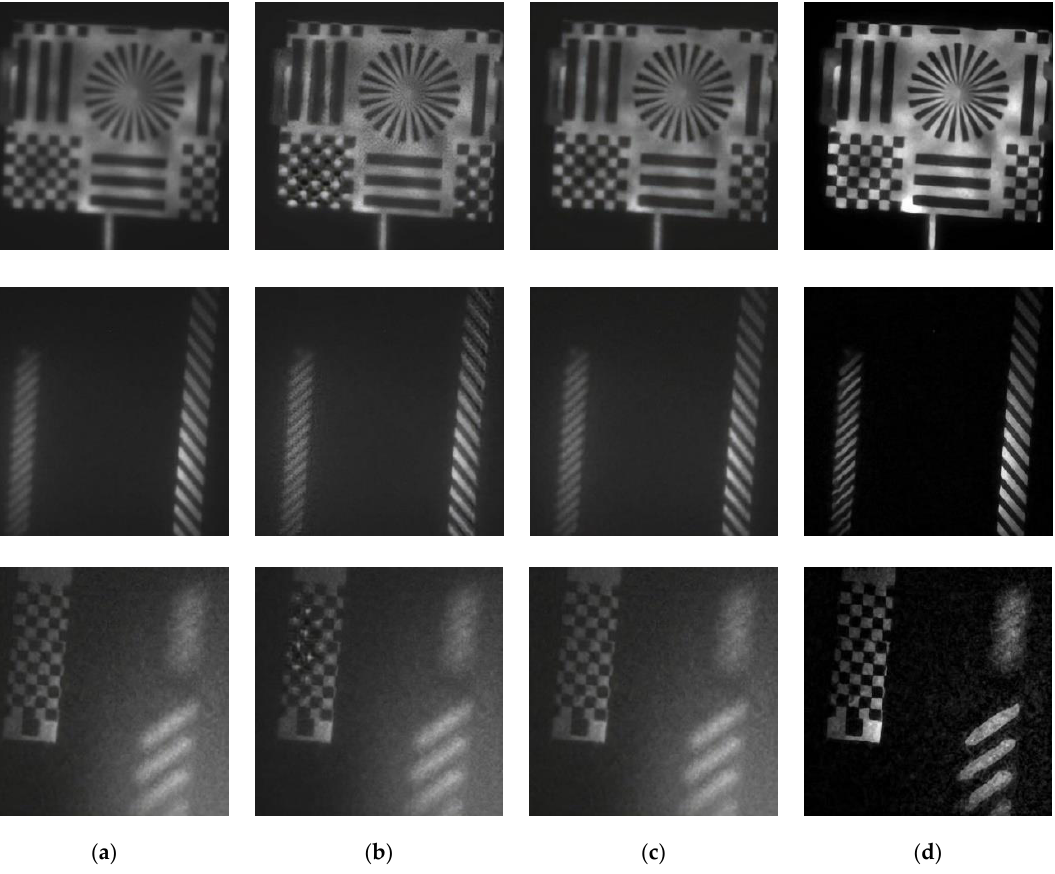
Figure 12. Visual comparison of three methods. The first row, the second row and the third row denoted as Test 1, Test 2 and Test 3: ( a ) images captured by PLRGI system; ( b ) results of KPAC (2-level); ( c ) results of GKMNet; ( d ) results of our proposed method.